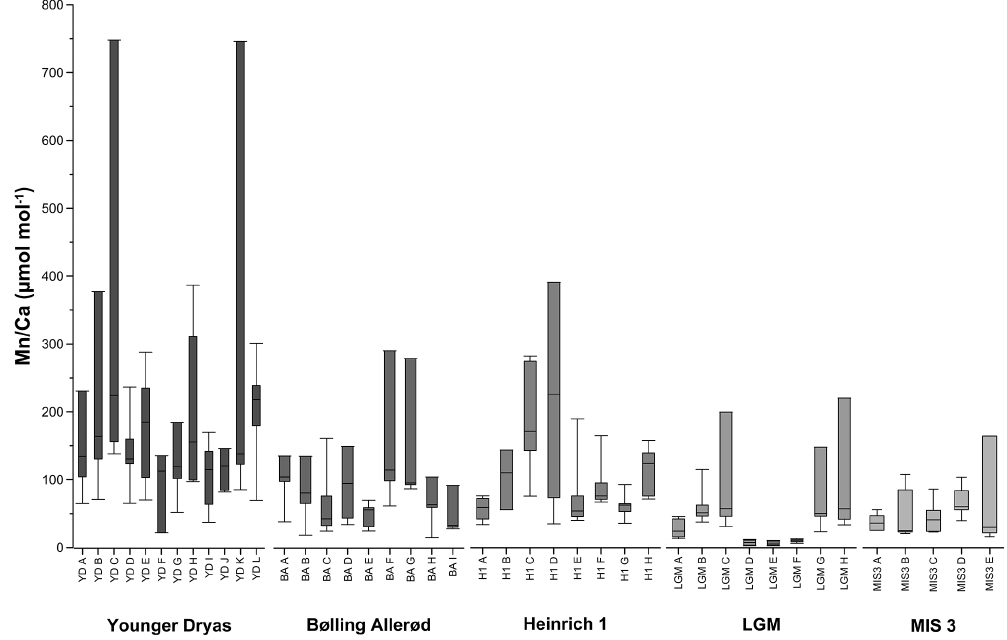
Figure 3. The Mn / Ca (µmolmol − 1 ) variability within each individual Eubuliminella exilis specimen for each climatic interval (labelled on the x axis), determined by